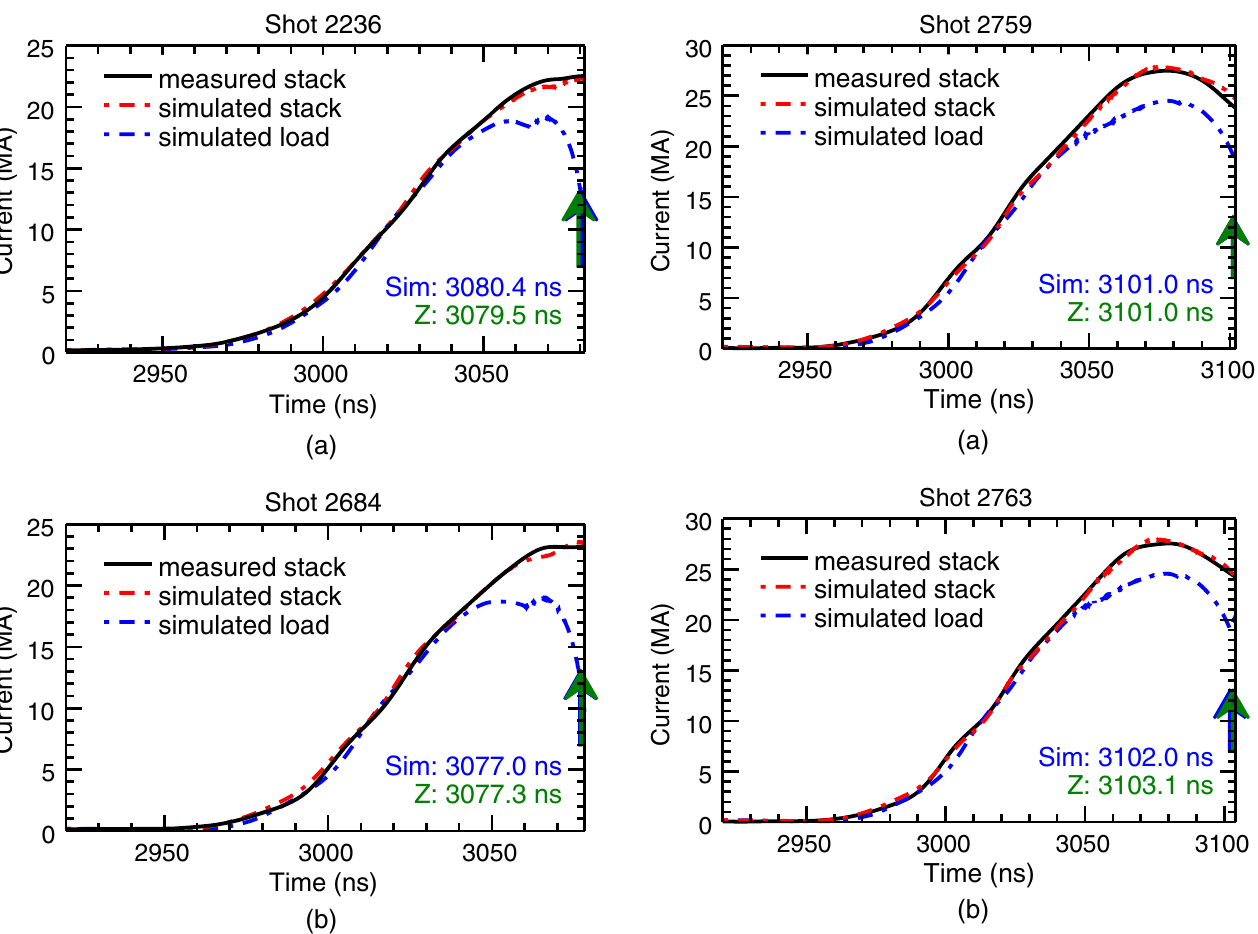
FIG. 11. Comparisonofsimulationandexperimentresultsoftwo dynamic-hohlraum shots [11]. (a) Z shot 2759, (b) Z shot